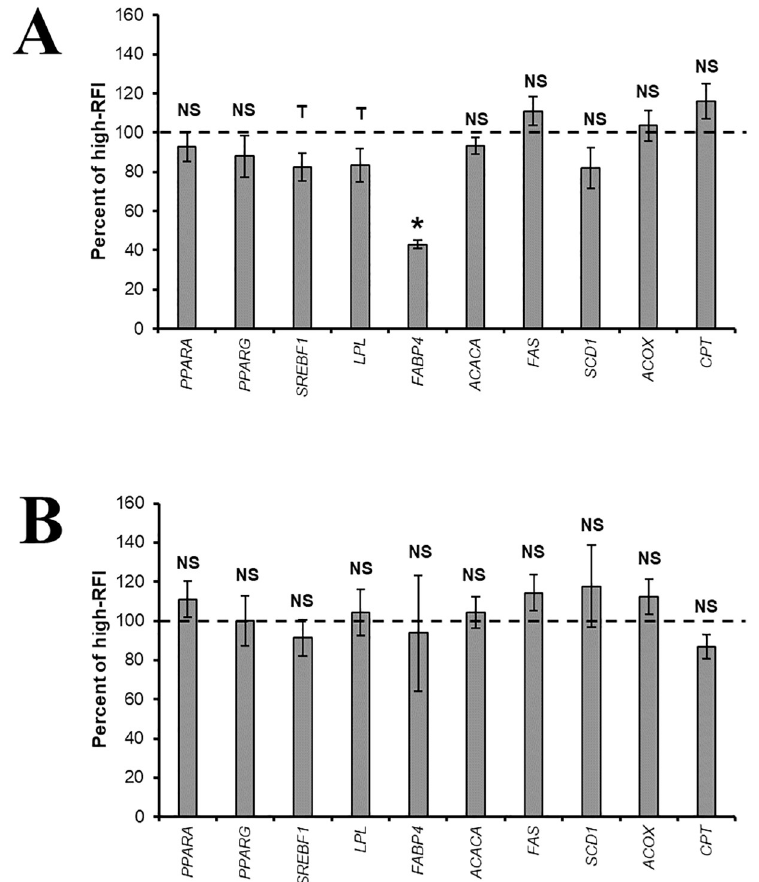
Fig 1. Gene expression in Longissimus muscle of Nellore calves born to cows classified as positive (dotted line) and negative (columns) residual feed intake (RFI) in Year 1. (A) Birth, (B) Weaning. The bars represent the standard deviation of the mean. Values with an asterisk ( � ) differ significantly (P � 0.05) and T indicates a tendency (0.05 < P � 0.15). NS: Not significant (P >